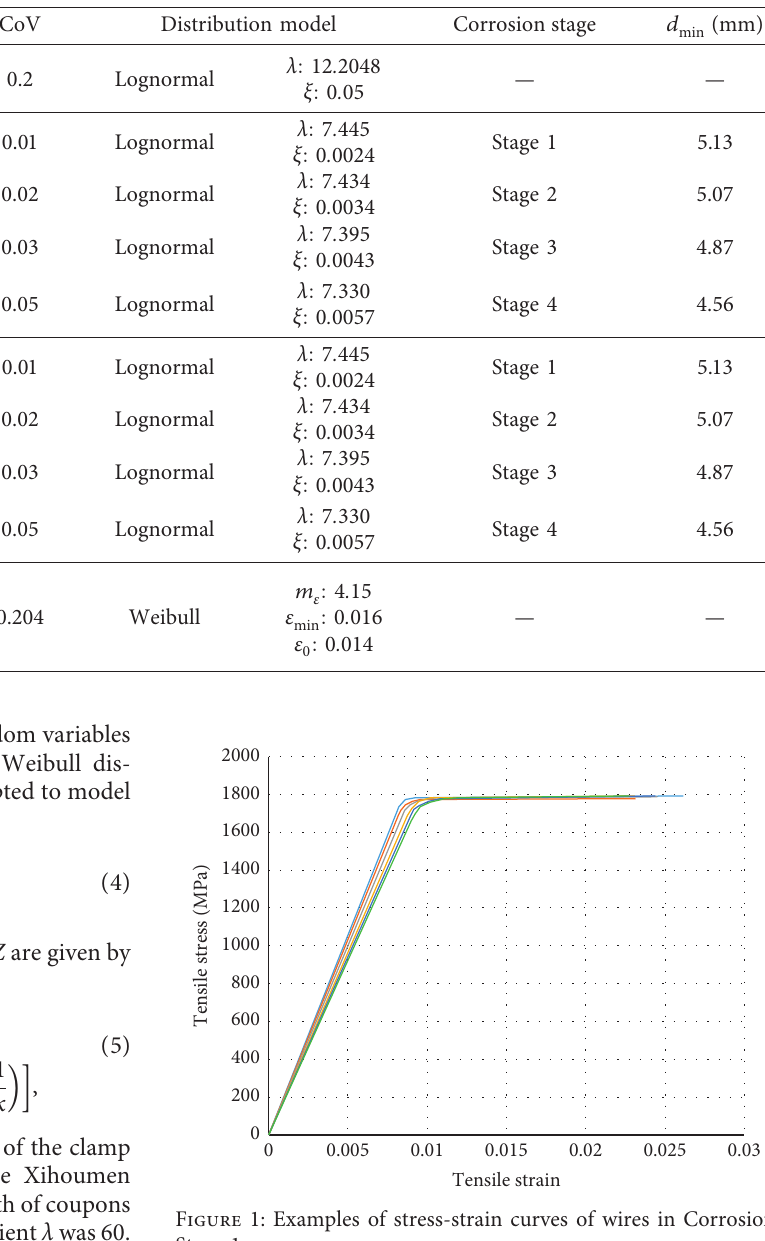
Table 1: Statistical parameters of steel wire distribution functions.